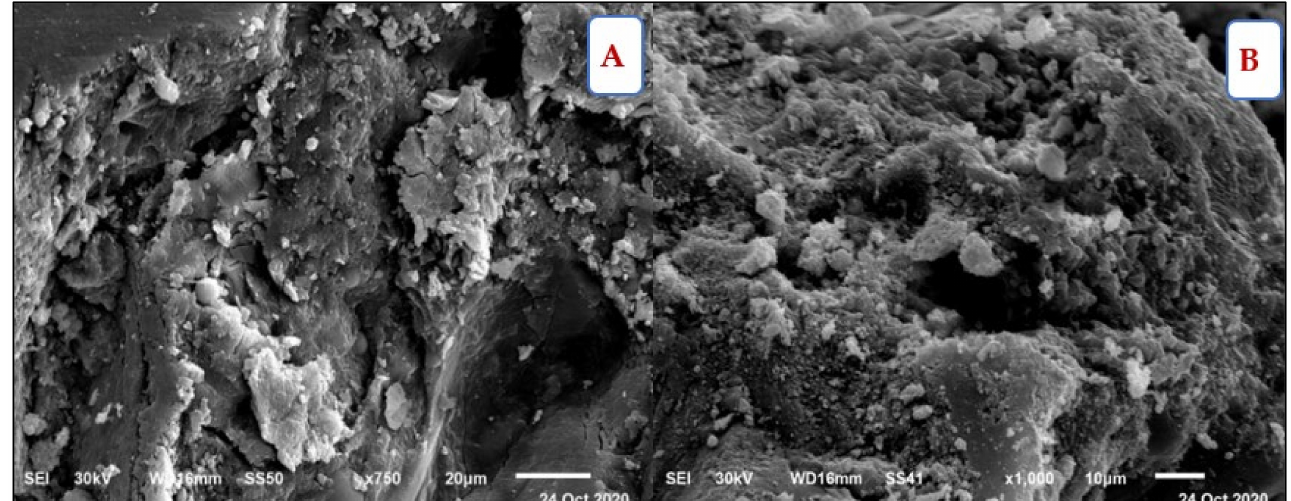
Figure 19. ( A ) Z1 microstructure SEM at 180 days under normal conditions, ( B ) Z6 microstructure SEM at 180 days under normal